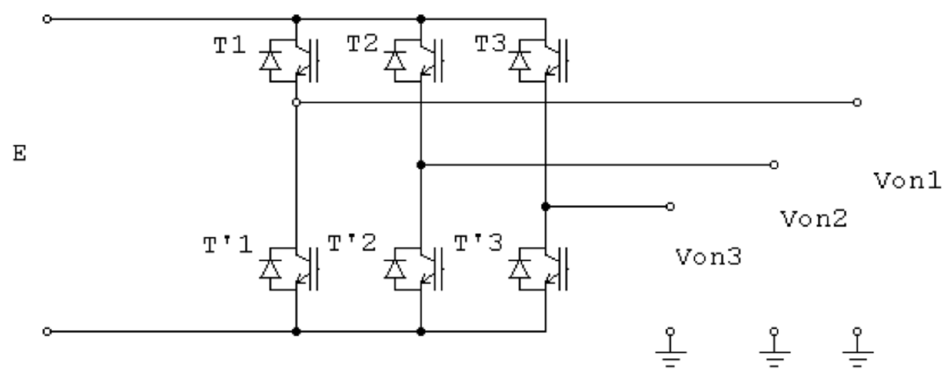
Figure 22. Chain studied: inverter with an asynchronous machine .